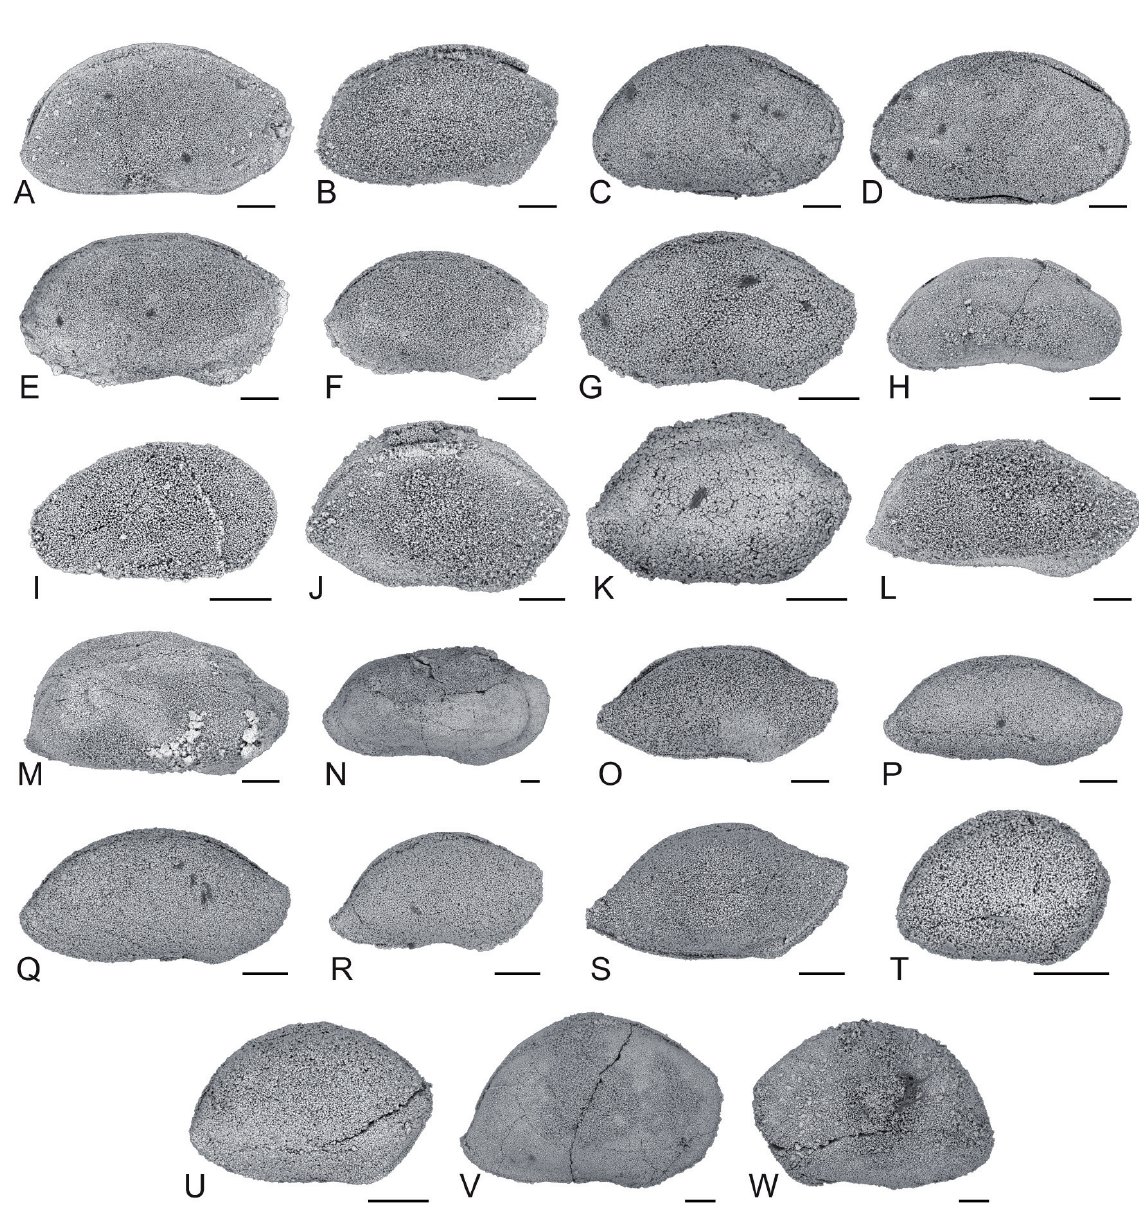
Fig. 9. Ostracods from the Dajiang section, South China. — A–D . Bairdia sp. 25. A . Carapace, right lateral view, P6M3011. B . Carapace, right lateral view, P6M3012. C . Carapace, right lateral view, P6M3013. D . Carapace, right lateral view, P6M3014. — E–G . Bairdia sp. 26. E . Carapace, right lateral view, P6M3015. F . Carapace, right lateral view, P6M3016. G . Carapace, right lateral view, P6M3017. — H–I . Bairdia sp. 27. H . Carapace, right lateral view, P6M3018. I . Carapace, right lateral view, P6M3019. — J-K . Bairdia sp. 28. J . Carapace, right lateral view, P6M3020. K . Carapace, right lateral view, P6M3021. — L–N . Bairdia sp. 29. L . Carapace, right lateral view, P6M3022. M . Carapace, right lateral view, P6M3023. N . Carapace, right lateral view, P6M3024. — O–Q . Bairdia sp. 30. O . Carapace, right lateral view, P6M3025. P . Carapace, right lateral view, P6M3026. Q . Carapace, right lateral view, P6M3027. — R-S . Bairdia sp. 31. R . Carapace, right lateral view, P6M3028. S . Carapace, right lateral view, P6M3029. — T–W . Bairdia sp. 32. T . Carapace, right lateral view, P6M3030. U . Carapace, right lateral view, P6M3031. V . Carapace, right lateral view, P6M3032. W . Carapace, left lateral view, P6M3033. – Scale = 100